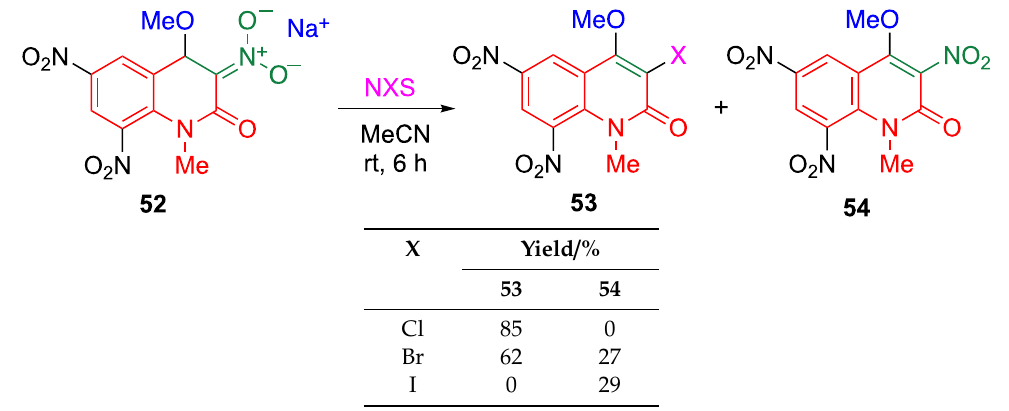
Table 18. Scanning of halogenating agents.